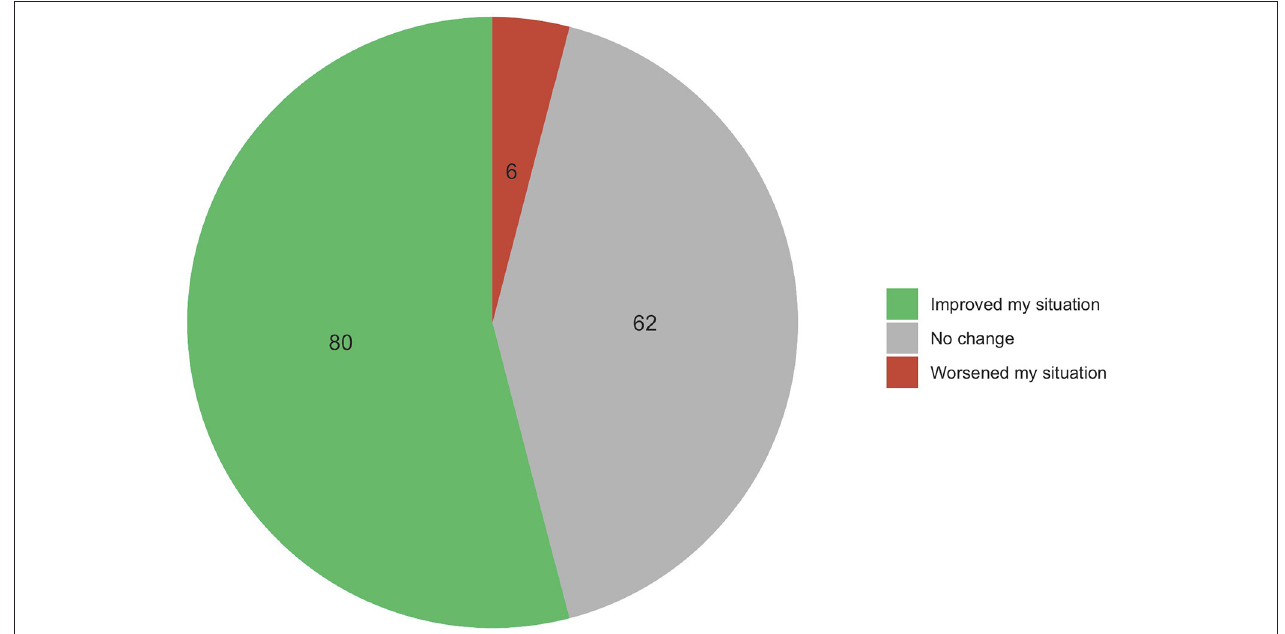
FIGURE 3 | Impact of professional coaching on pediatricians’ job satisfaction.